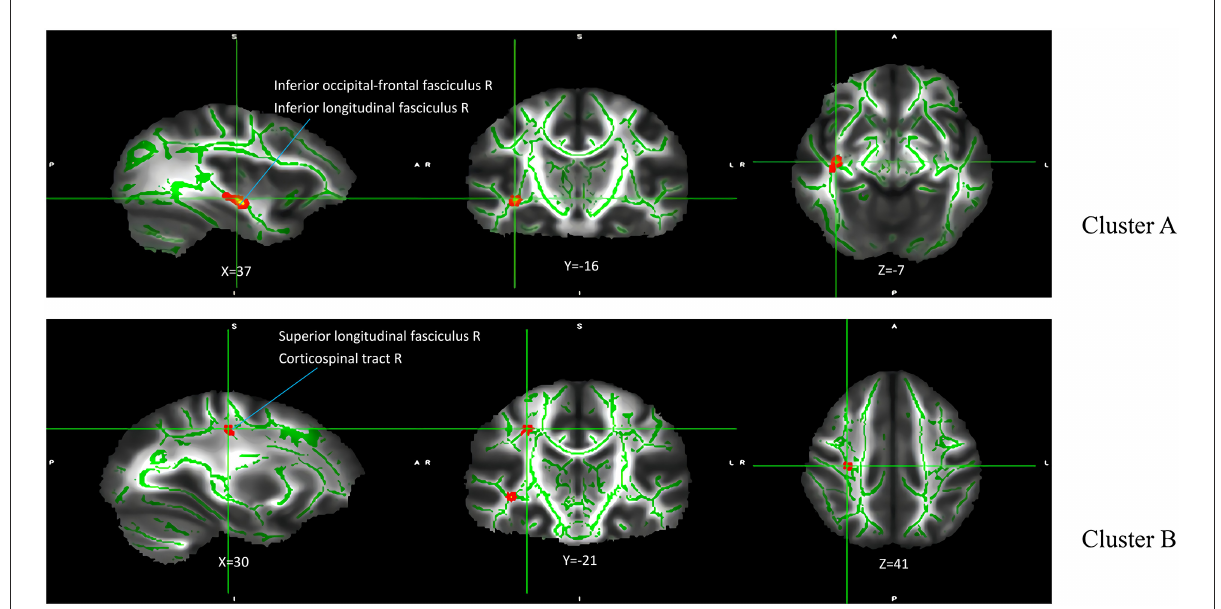
FIGURE3 Main effect of genotype on FA among the four groups. The green regions indicate FA white matter skeletons. Red-yellow regions indicate significantly different FA between the four groups. All statistical maps are thresholded at P < 0.05 (after TFCE correction for multiple comparisons).